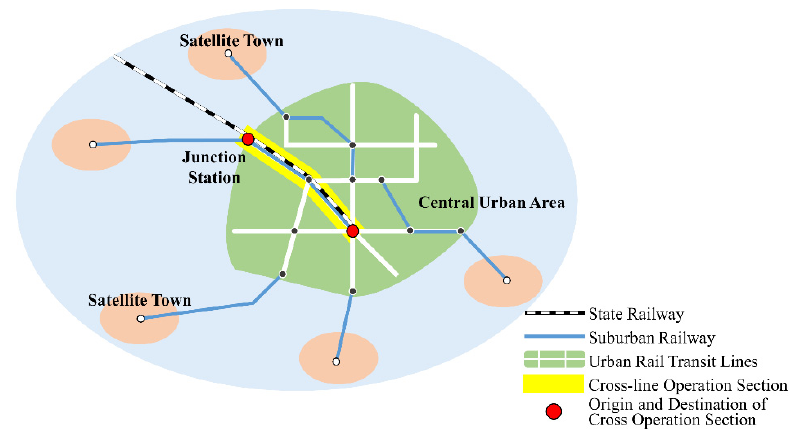
Figure 1. “Y” type cross ‐ line operation between the state railway and suburban railway.